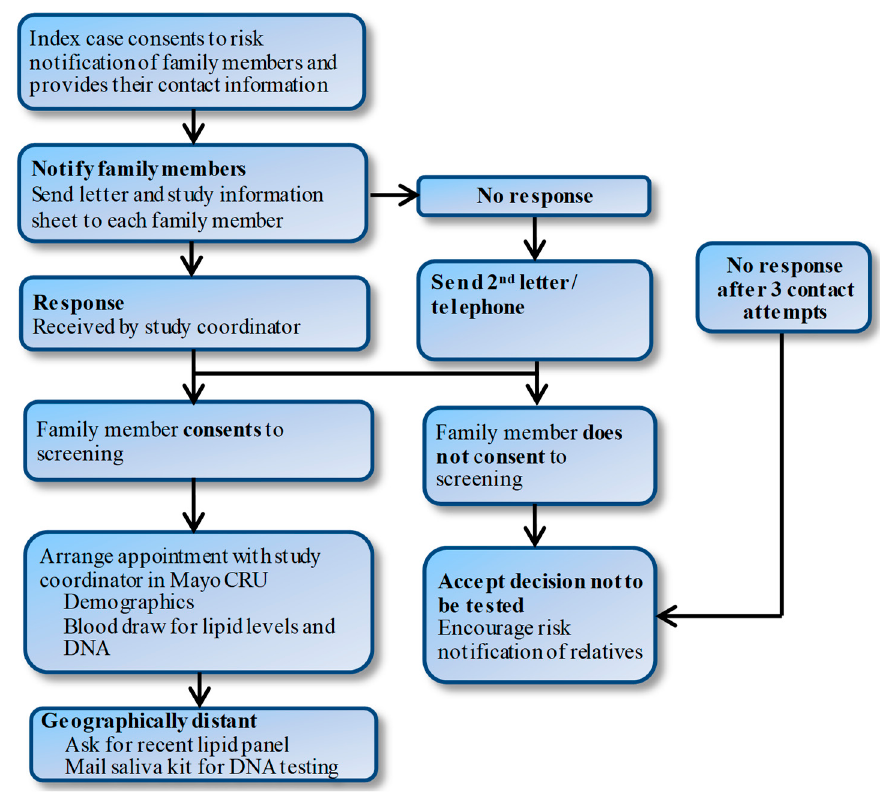
Figure 2. Proposed approach for cascade screening for FH. CRU: clinical research unit.